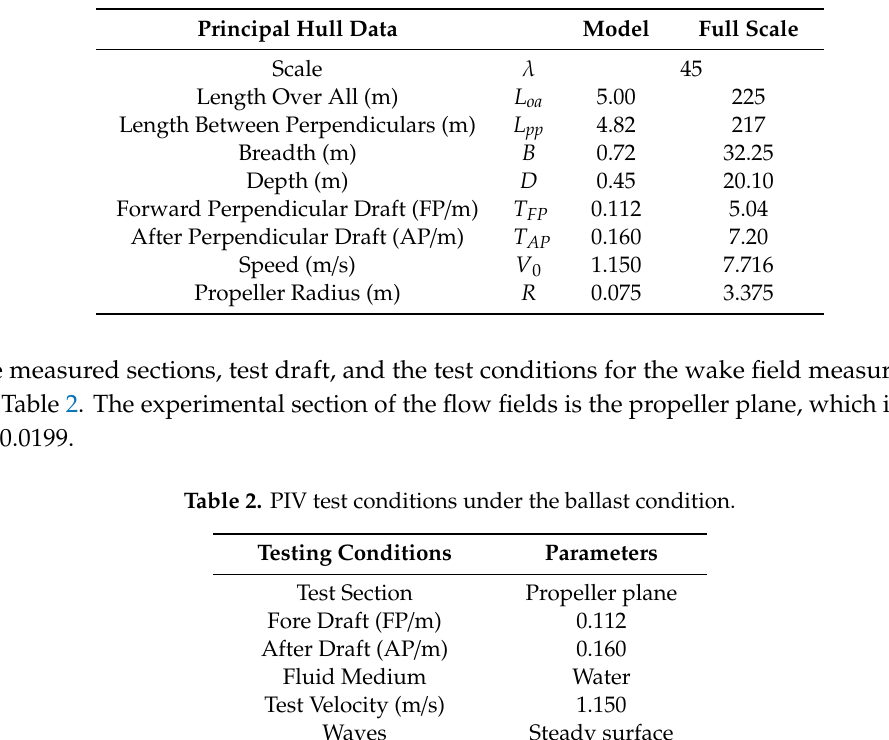
Figure 1. Lines plan and the geometric model. Table 1. Main parameters of the test model.